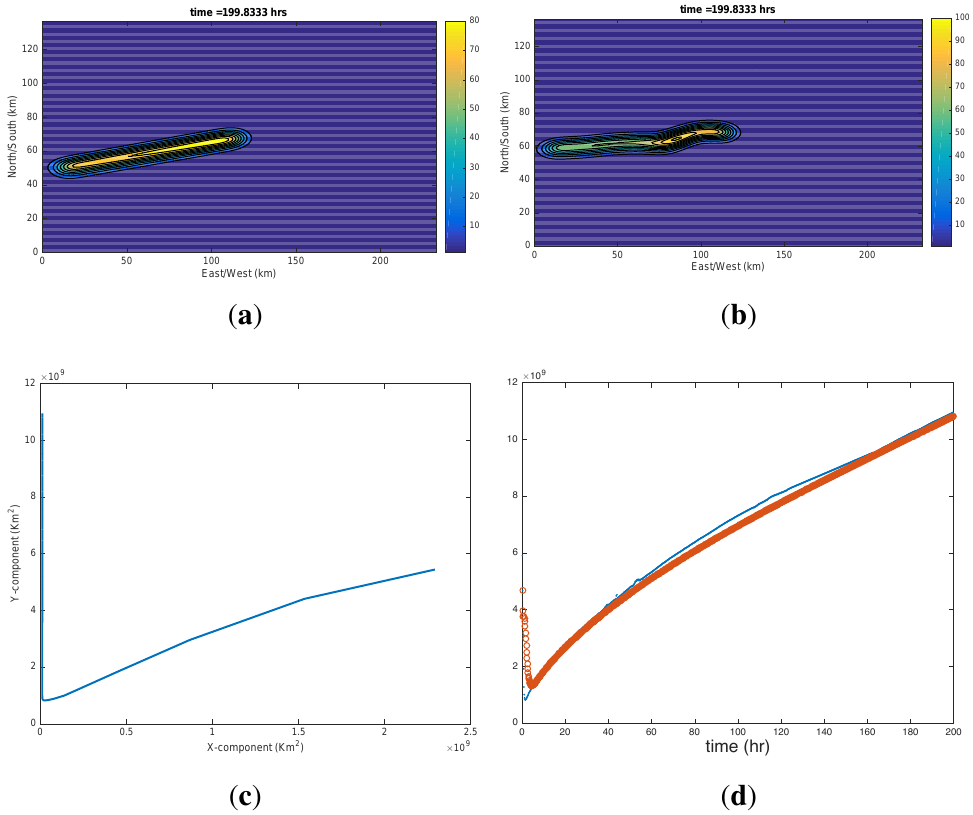
Figure 16. Tracer at the final time due to a steady source, located in the middle of the domain. Winter conditions. ( a ) Currents only; ( b ) Currents and Stokes drift. ( c ) Mean square distance corresponding to case ( b ); ( d ) Empirical variance corresponding to currents only (thick line), and currents and waves (thin line). The currents are overwhelming and thus the waves have a minor effect on the evolution of the spill, mostly at short times. Advection due to Stokes Drift velocity only. The time interval between points is 10